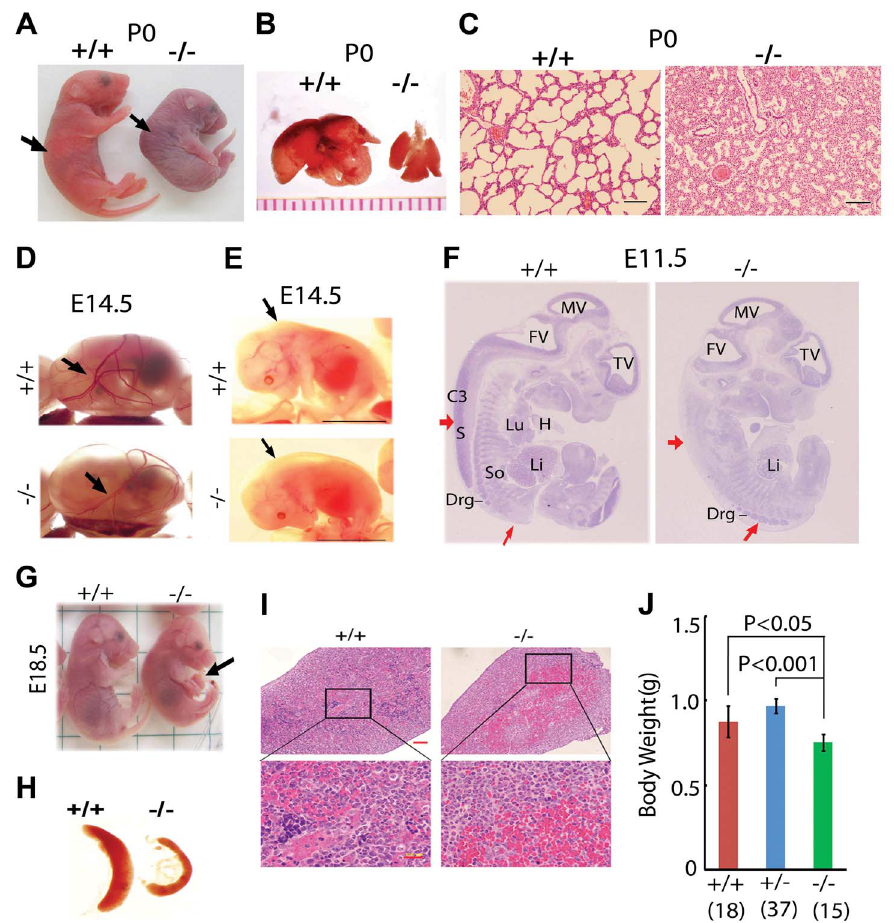
Figure 1. Postnatal lethality and multiple organ defects of Jmjd3 2 / 2 embryos. ( A ) Postnatal lethality of Jmjd3 2 / 2 mice. The skin color of Jmjd3 2 / 2 mice became cyanotic minutes after birth. Arrowhead indicates defective lordosis in Jmjd3 2 / 2 newborns. ( B ) The lungs of Jmjd3 2 / 2 mice were smaller and not expanded at P0 compared with Jmjd + / + mice. ( C ) H&E staining of P0 lung sections from Jmjd3 2 / 2 mice indicates arrested tissue maturation. ( D ) Less developed yolk sac vascular plexus of Jmjd3 2 / 2 embryos at E14.5. ( E ) Subcutaneous edema on the dorsal region of Jmjd3 2 / 2 embryos at E14.5. ( F ) H&E staining of sagittal sections of Jmjd3 2 / 2 embryos at E11.5 indicating defective spinal cord and somite development. S, spinal cord; So, somite; Drg, dorsal root ganglion; H, heart; Lu, lung; Li, liver; C3, centrum of C3; TV, third ventricle; FV, fourth ventricle; MV, mesencephalic vesicle. ( G ) Failure of umbilical cord resorption (arrowhead) in E18.5 Jmjd3 2 / 2 embryos. ( H ) The spleens of Jmjd3 -deficient embryos at E17.5 were smaller than those of WT embryos. ( I ) H&E staining showing multiple hyperemic areas in the spleen of Jmjd3 2 / 2 embryos. ( J ) Body weight of Jmjd3 2 / 2 embryos was significantly lower than that of WT and Jmjd3 + / 2 controls. Data are presented as the mean 6 SD. Differences in body weight were analyzed using the Student’s t